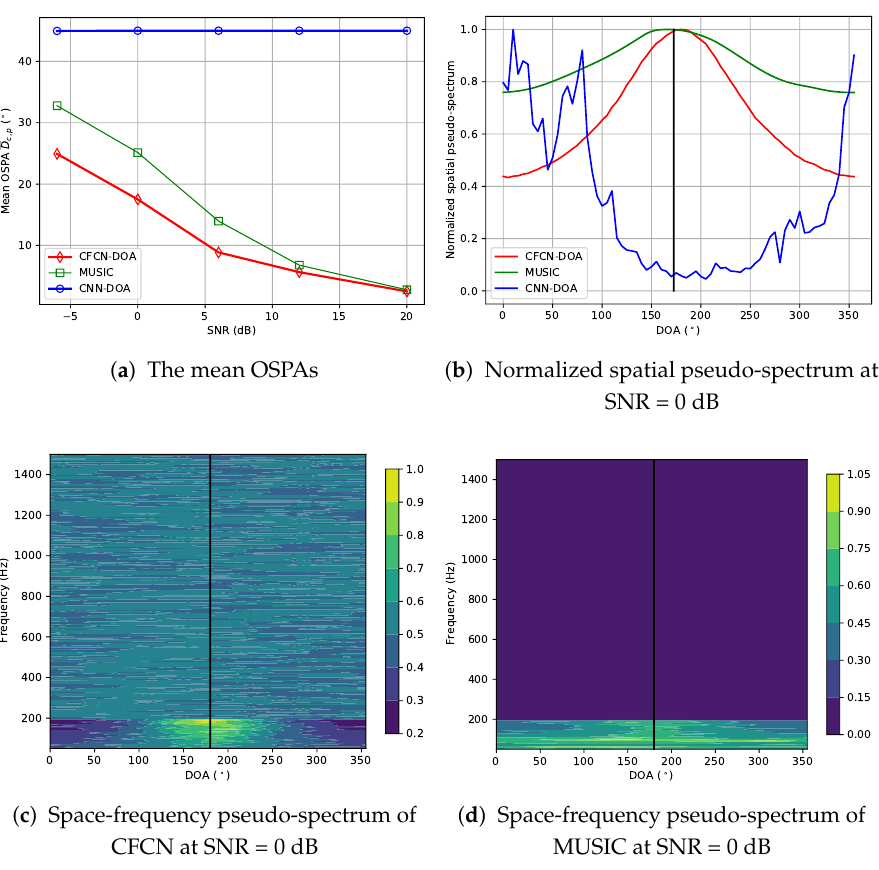
Figure 4. The results of the simulation under the low-frequency single-source